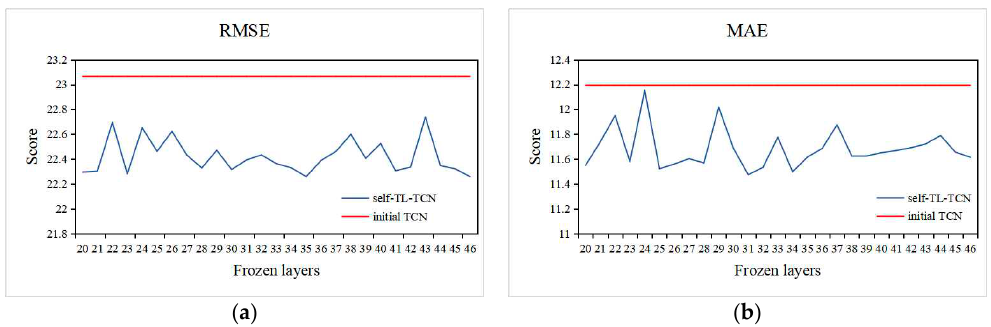
Figure 12. Prediction results before and after TCN optimization.